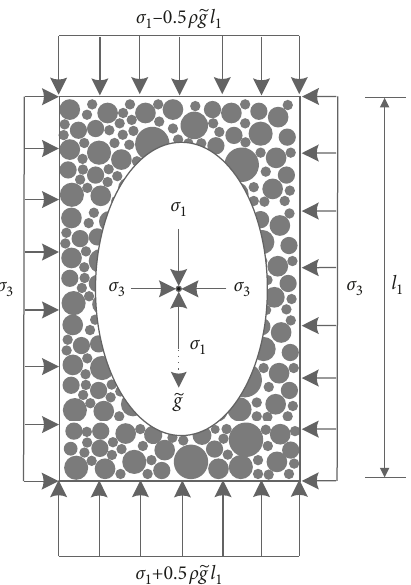
Figure 1: Physical model of the RVE for triaxial testing. σ are the major and minor principal stress, respectively, and 􏽥 g is the predetermined gravity acceleration. Table 1: Parameters of particles and boundaries. Entity Particle Boundary Normal stiffness (N/m) Shear stiffness (N/m) Density (kg/m 3 ) 2630 — Radius ratio ∗ 2.05 — Local damping coefficient 0.70 0.70 Friction coefficient 0.50 0.00 Note. ∗ Radius ratio � maximum radius/minimum